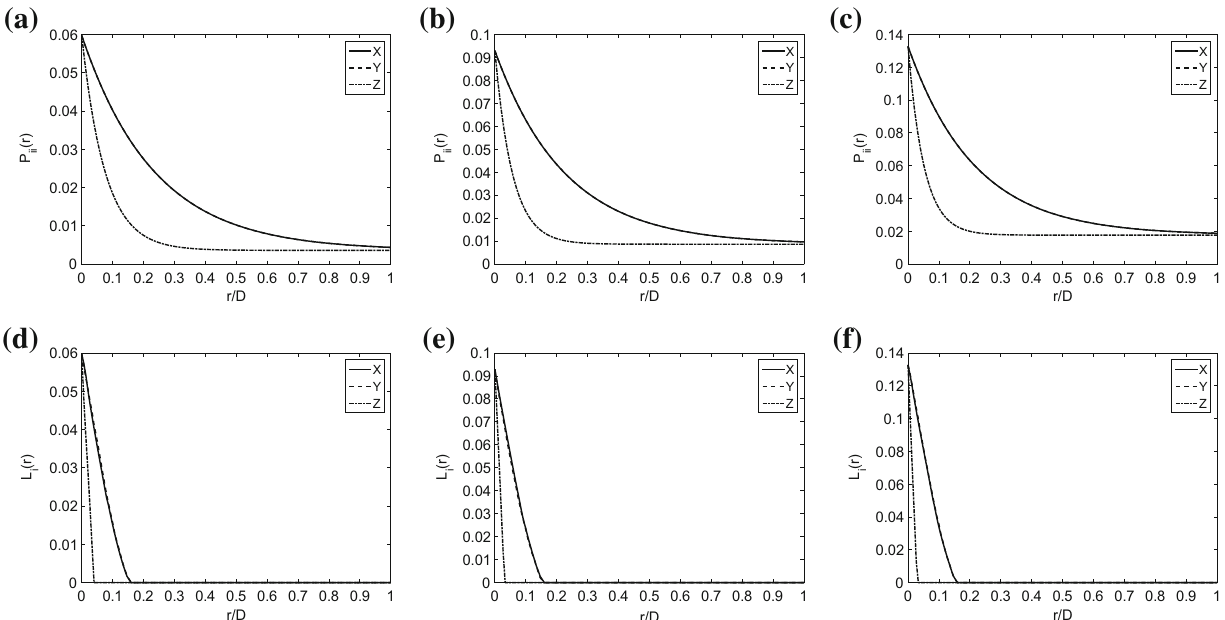
Fig. 4 Probability functions of the specimens: a P ii ð r Þ for L3 sample, b P ii ð r Þ for L6 sample, c P ii ð r Þ for L9 sample, d L i ð r Þ for L3 sample, e L i ð r Þ for L6 sample, f L i ð r Þ for L9 sample ( Note D is the edge length of the sample, and r is the distance between two